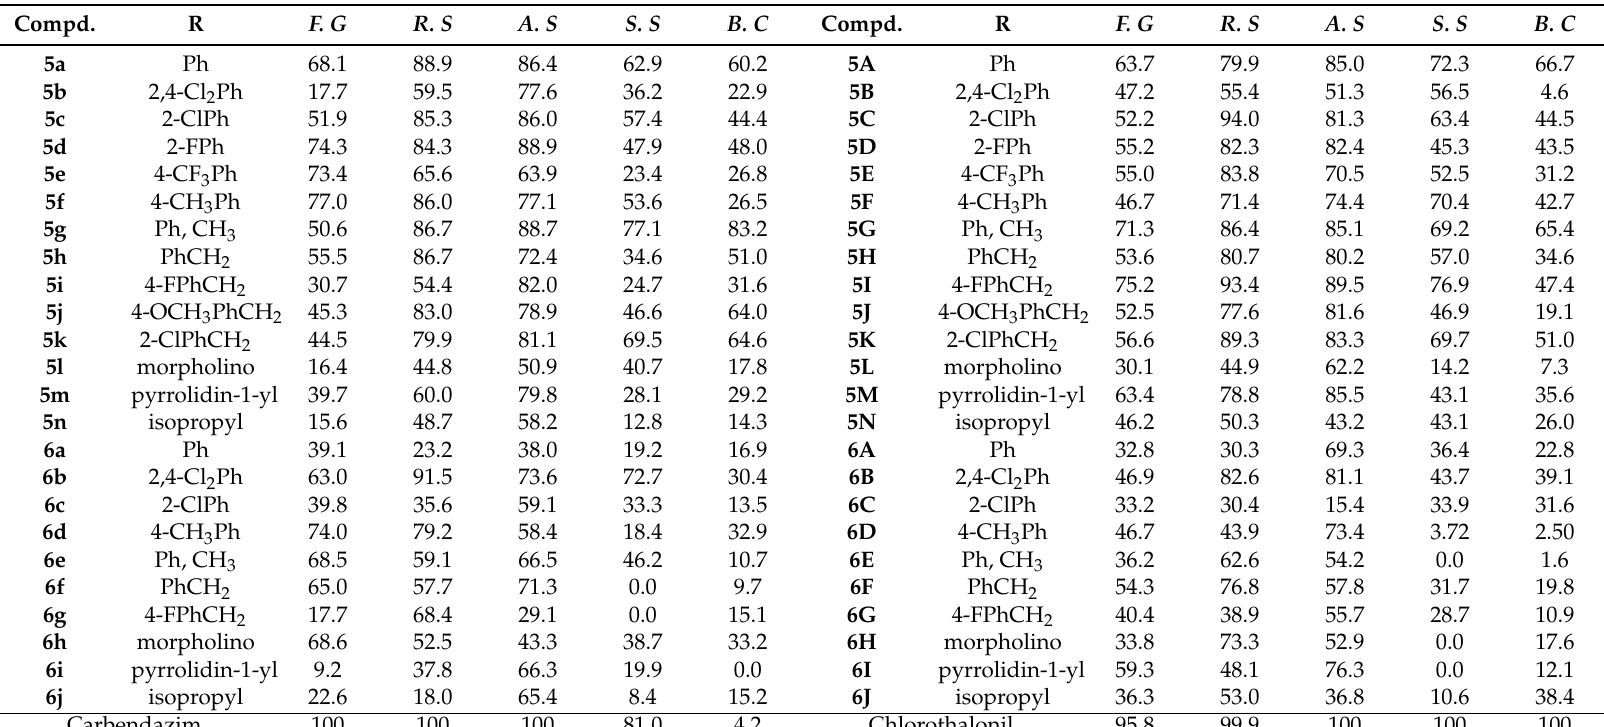
Table 1. The fungicidal activities (inhibition rate, %) of compounds 5 and 6 at 50 µ g/mL a .